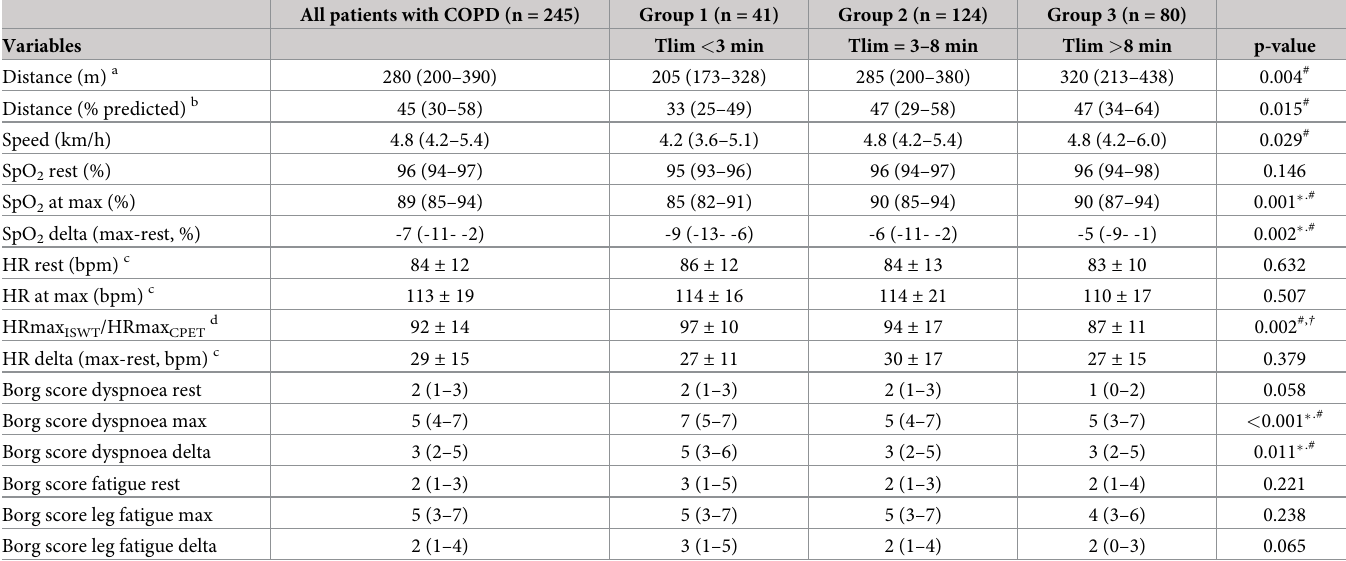
Table 2. ISWT performance parameters of the whole group and the three subgroups based on tolerated duration during the ESWT. All patients with COPD (n =